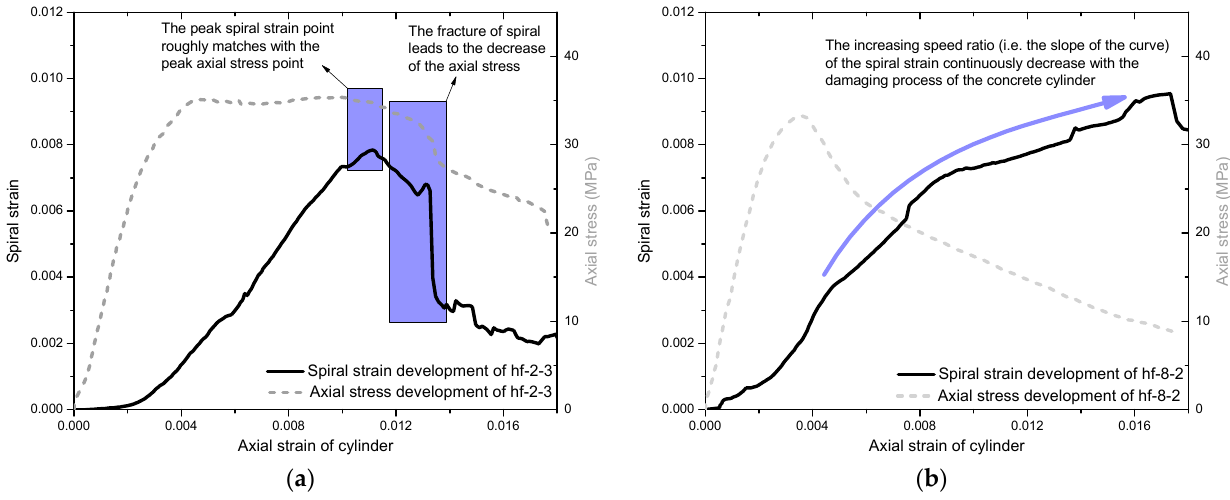
Figure 6. Development mechanism of spiral strain in typical cylinders: ( a ) in hf-2-3 and ( b ) in hf-8-2.